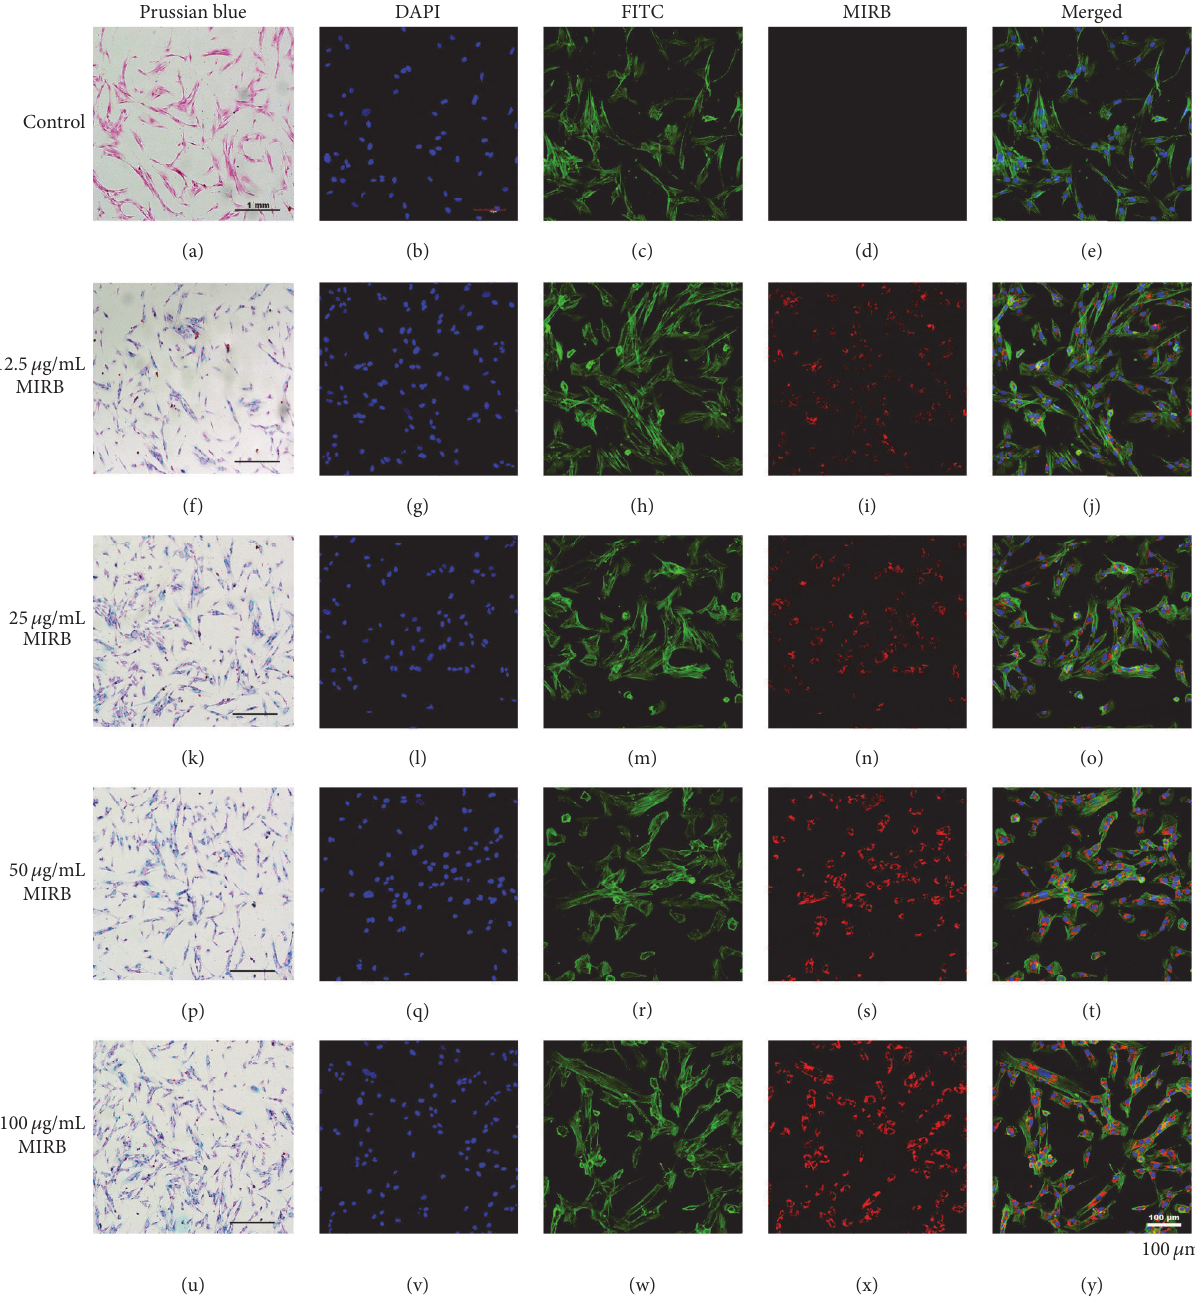
Figure 2: Morphological observation of hDPSCs labeled with various concentrations of MIRB. Light microscopy images: (a) Prussian blue staining of unlabeled control hDPSCs; (f, k, p, u) Prussian blue staining of 12.5 𝜇 g/mL–100 𝜇 g/mL MIRB-labeled hDPSCs. The scale bar indicates1mm.Fluorescencemicroscopyimages:(b,g,l,q,v)thenucleiofhDPSCsarestainedwithDAPI(blue);(c,h,m,r,w)thecytoskeleton is stained with FITC-phalloidin (green); (d, i, n, s, x) the MIRB particles show red; (e, j, o, t, y) merged images of nuclei, cytoskeleton, and MIRB. The scale bar indicates 100 𝜇